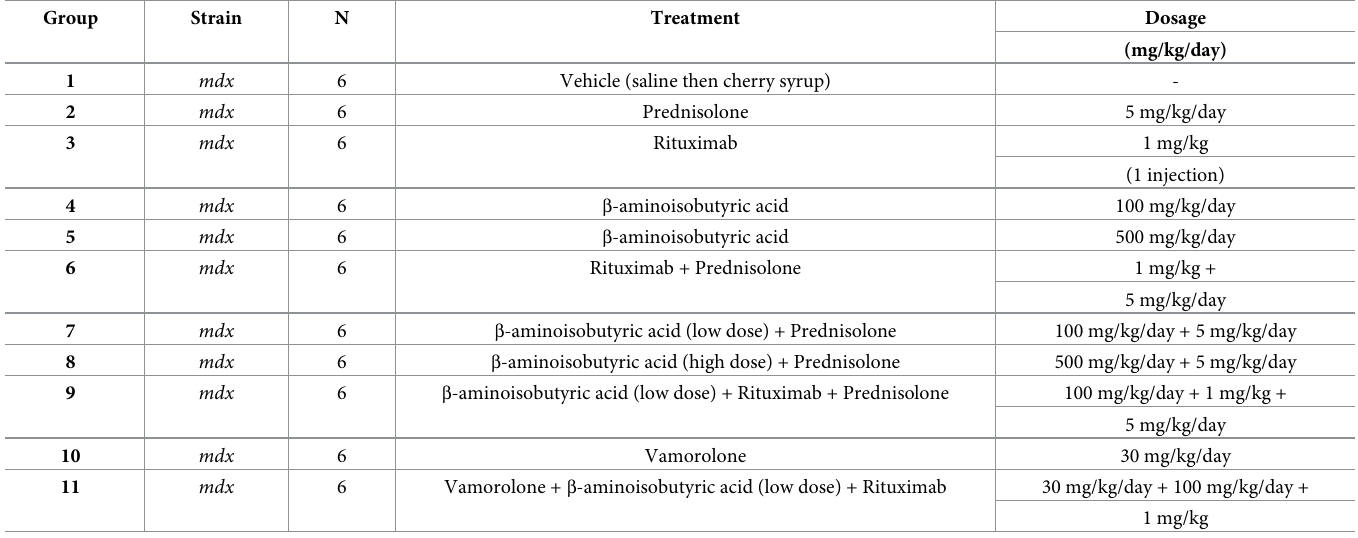
Table 1. Drug treatment regimens used in dystrophin-deficient mdx mice.